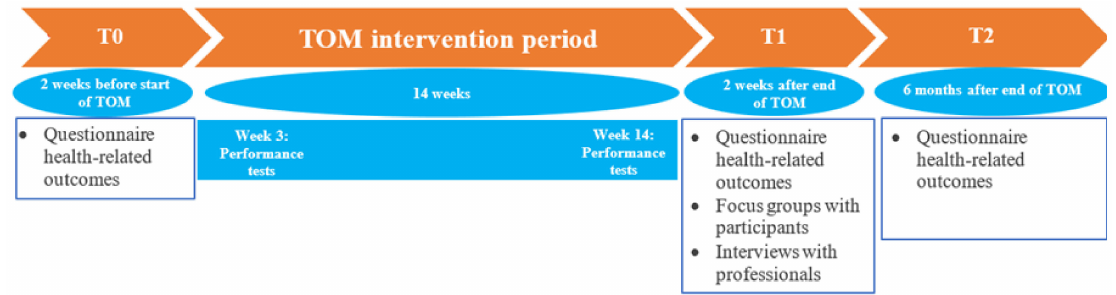
Figure 2. Study design of the current research. T0 = measurements before the start of the programme; T1 = measurements two weeks after the end of the programme; and T2 = measurements six months after the end of the